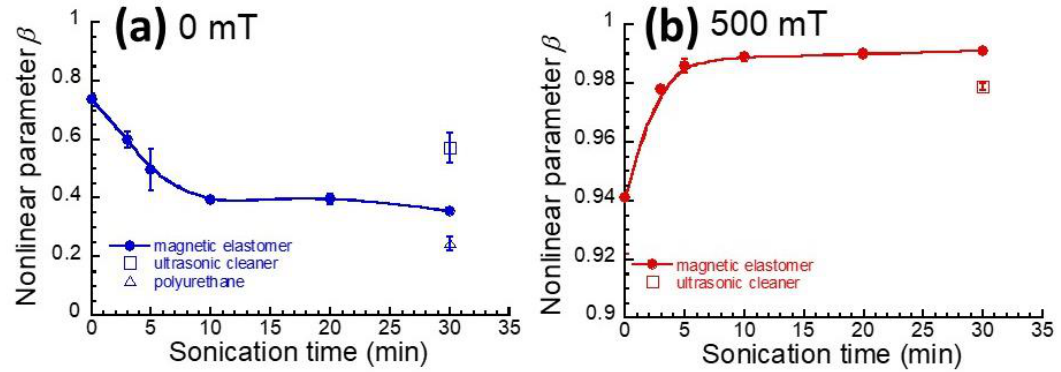
Figure 3. Relationship between storage modulus for magnetic elastomers at γ = 1 and sonication time at 0 mT and 500 mT.